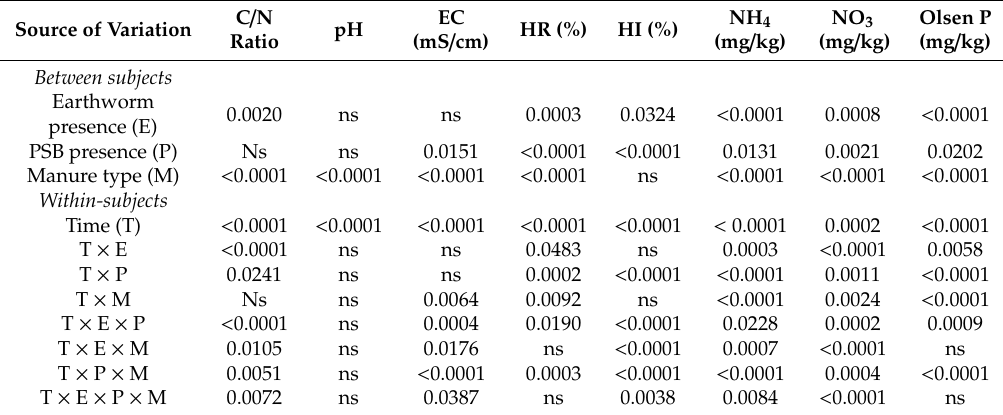
Table 2. Repeated measure analysis (ANOVAR) for changes in biochemical properties of rock phosphate enriched cow manure and pig manure waste paper mixtures inoculated with E. fetida and P. fluorescence after 10 weeks of vermicomposting.